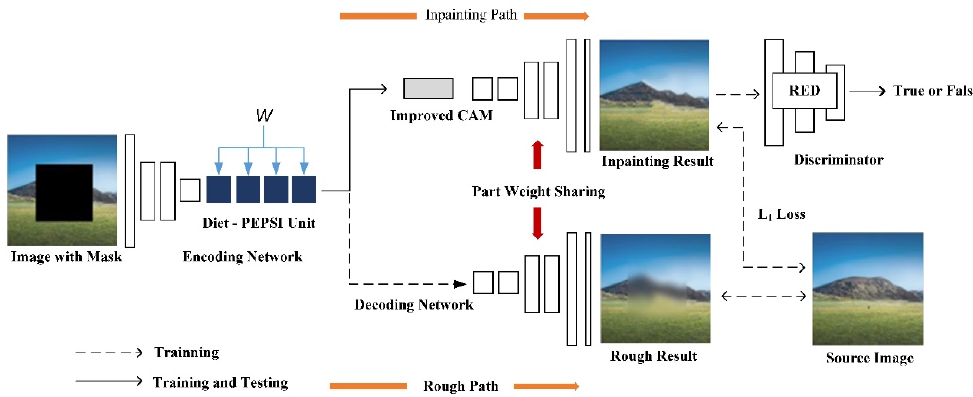
Figure 2. Architecture of the proposed network model.